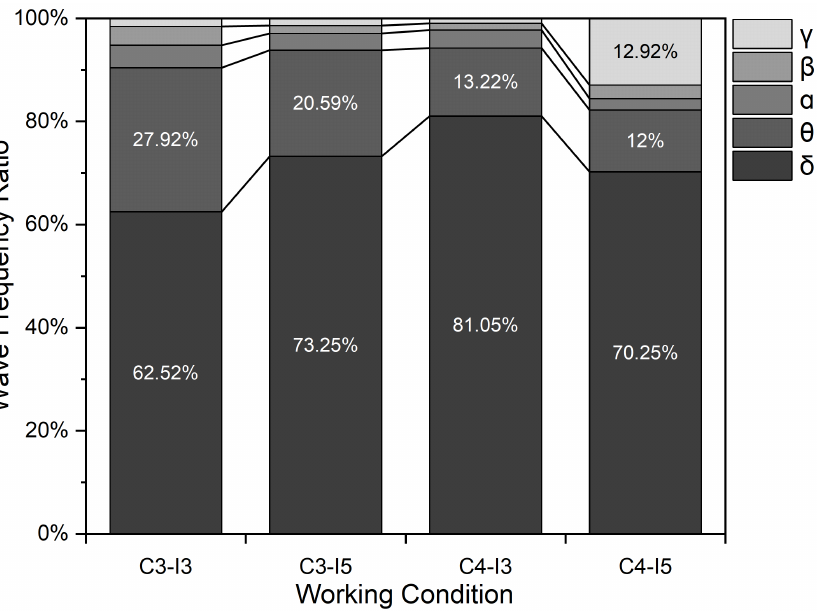
Figure 8. Proportions of different EEG frequency bands.